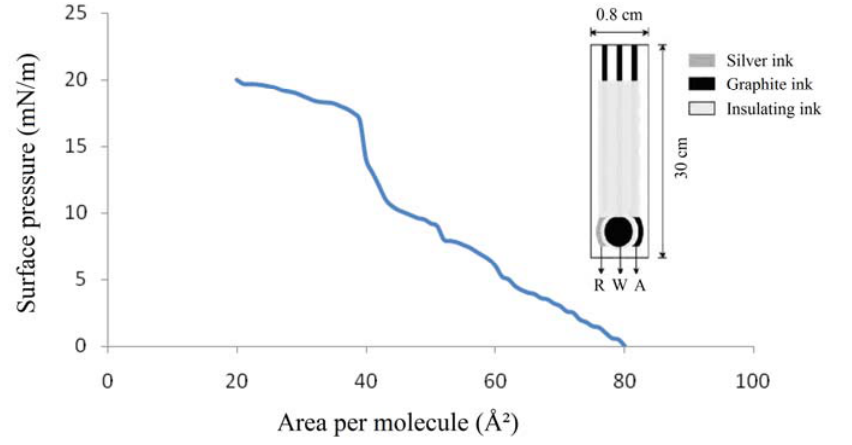
Figure 5. π -A isotherm of the laccase thin film at the air-water interface ( Left ). A couple of screen-printed electrodes used as a transducer based on graphite/ruthenium ink and the counter on silver one ( Right